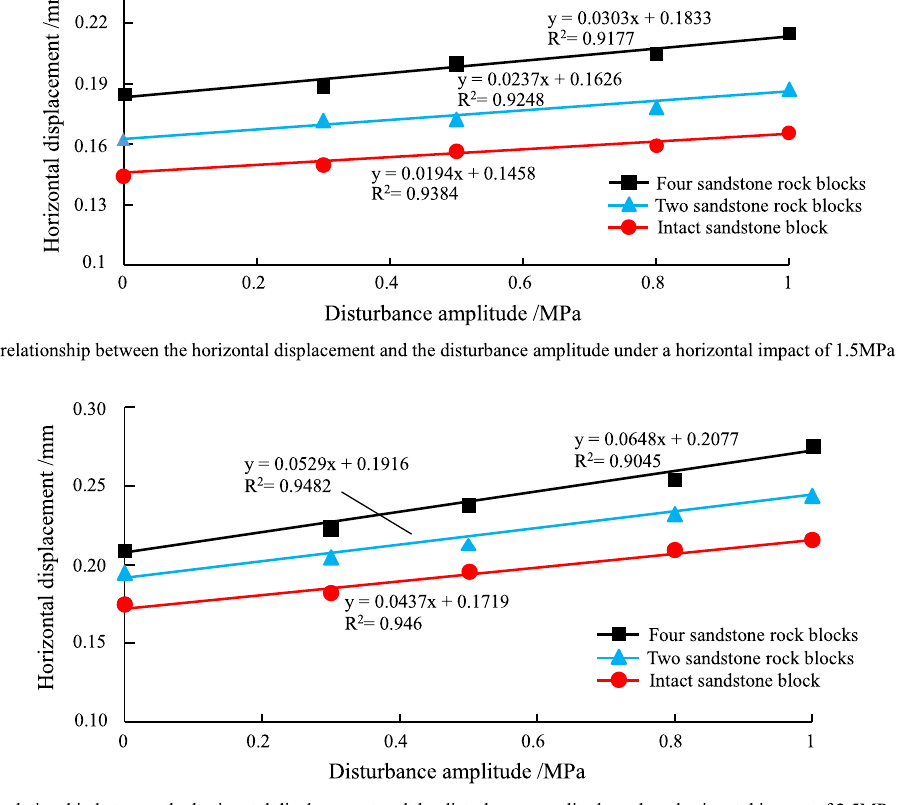
Fig. 9 Relationship between horizontal displacement and disturbance amplitude under different levels of horizontal